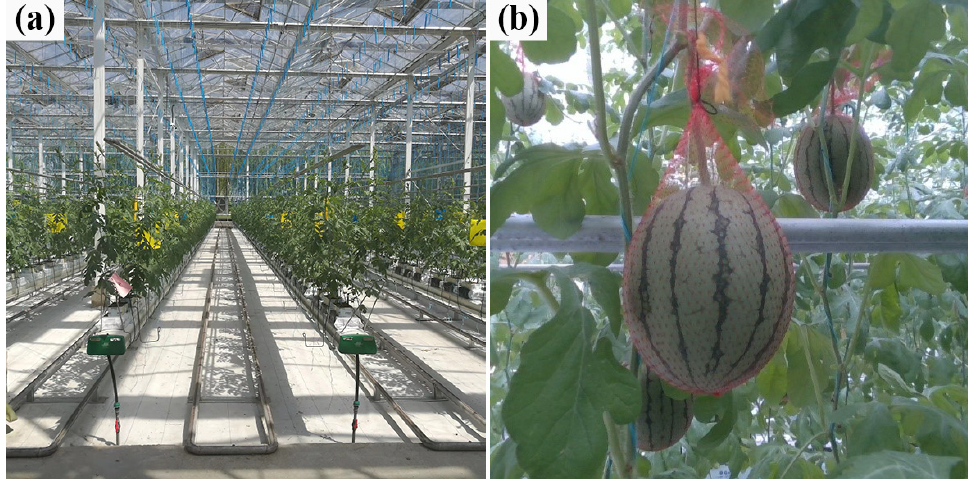
Figure 1. A modern greenhouse for growing watermelons: ( a ) the production greenhouse scenario; ( b ) elevated soilless watermelons.